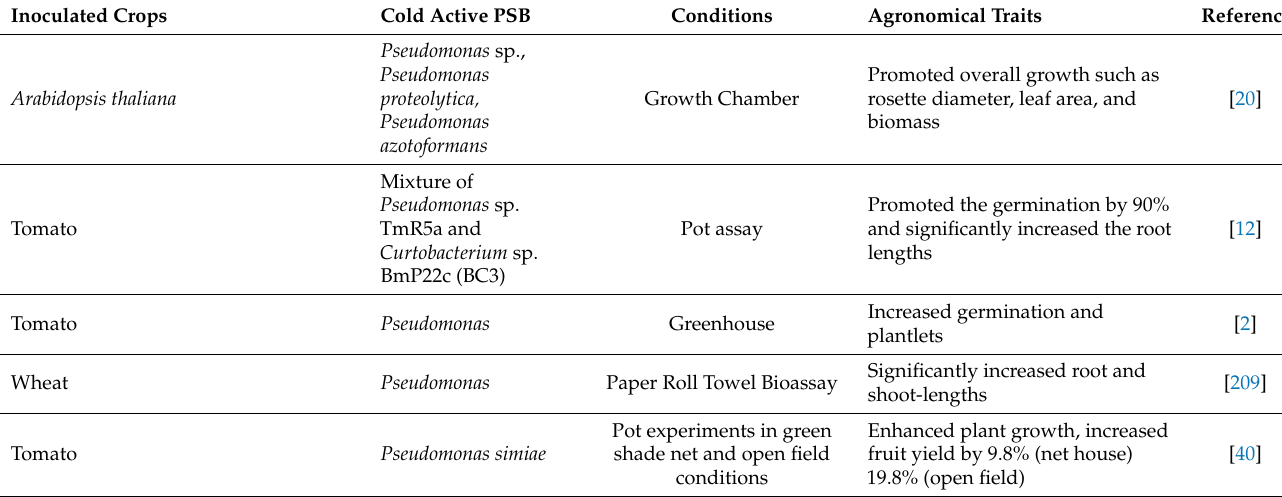
Table 4. Inoculation effect of psychrophilic/psychrotolerant phosphate biofertilizers on different crops. Inoculated